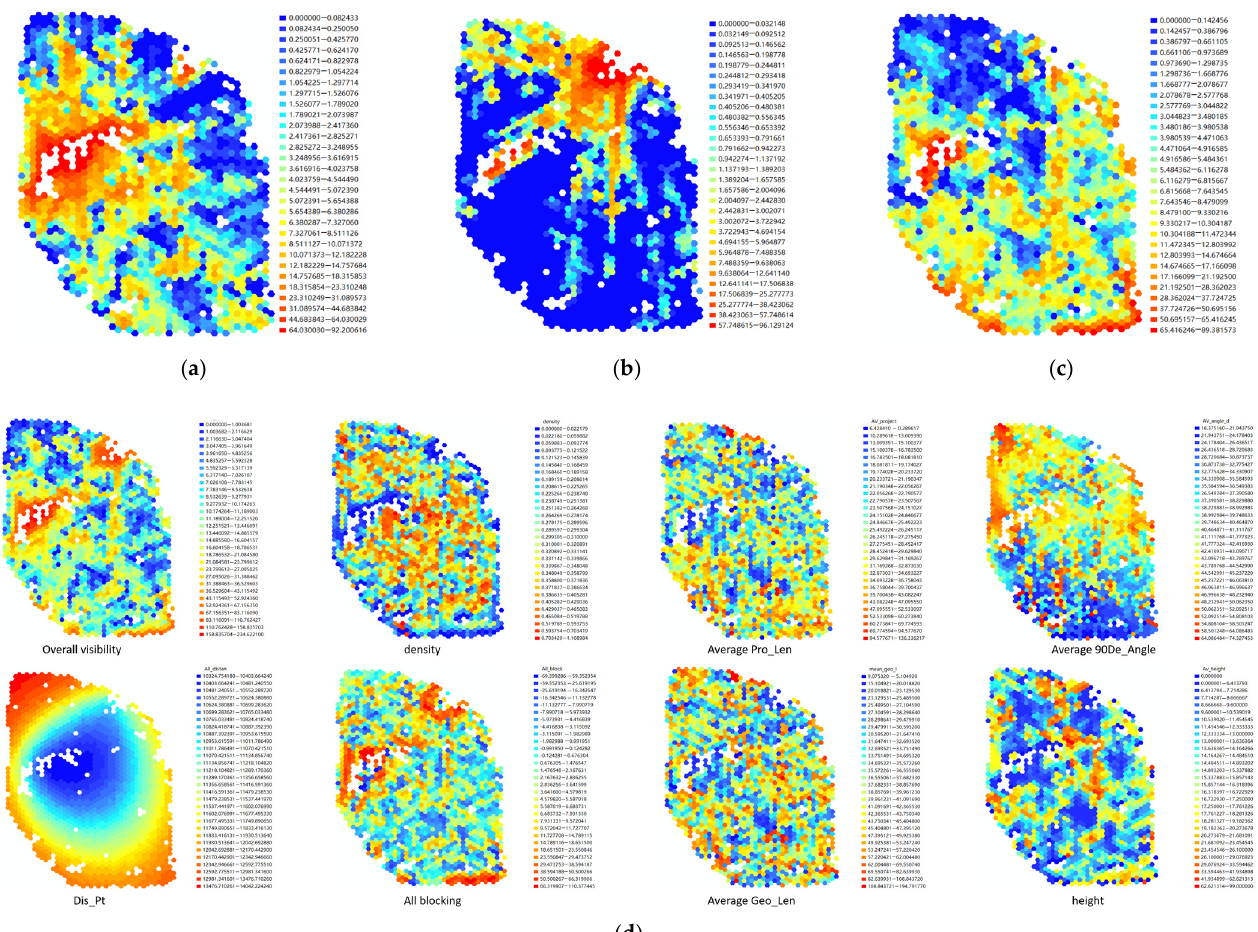
Figure 5. Correlated variables with the landscape visual value of the global calculation: ( a ) high obstruction area for landscape A; ( b ) high obstruction area for landscape B; ( c ) high obstruction area for landscape C; ( d ) spatial explanation of the variables, including overall visibility, density, Pro_Len, 90De_Angle, Dis_Pt, overall blocking of view, Geo_Len, and height.